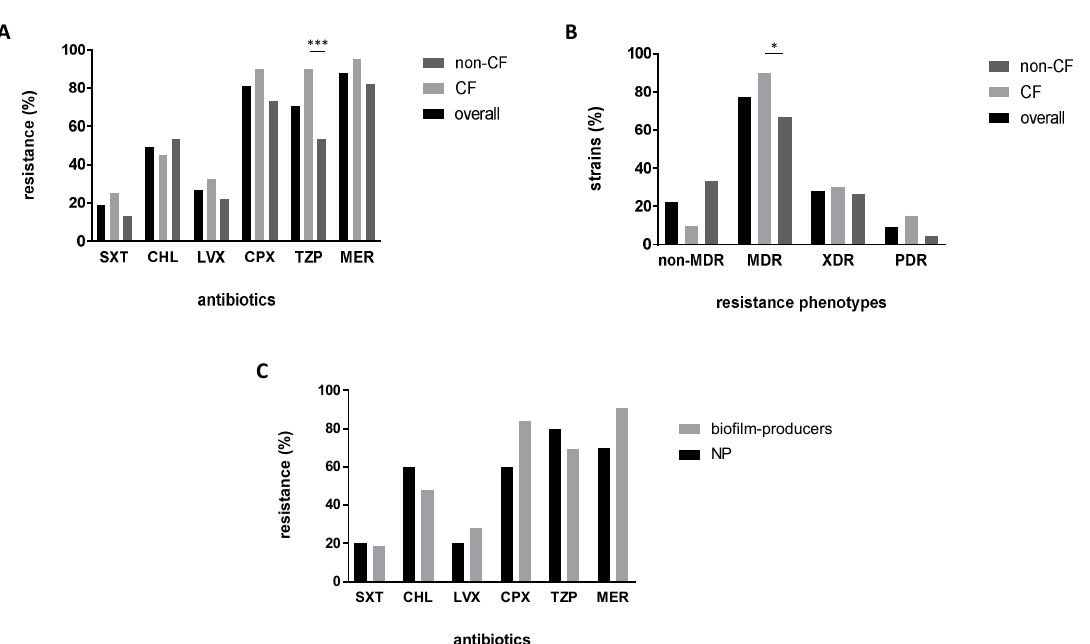
Figure 1. Distribution of antibiotic resistance rates and profiles. S. maltophilia strains were evaluated for in vitro susceptibility to six antibiotics: SXT, cotrimoxazole; CHL, chloramphenicol; LVX, levofloxacin; CPX, ciprofloxacin; TZP, piperacillin/tazobactam; MER, meropenem. The frequencies of ( A ) antibiotic resistances, and ( B ) multiresistance profiles (non-MDR, MDR, XDR, and PDR) were calculated for cystic fibrosis (CF) ( n = 40), non-CF ( n = 45), and overall ( n = 85) strains. ( C ) Resistance rates were calculated according to the capability to form biofilm: non-producers (NP; n = 10) or biofilm-producers ( n = 75; gathering strong, moderate, and weak-producers). Significance level at Fisher’s exact test: * p < 0.05; *** p < 0.001. Resistance profiles according to Magiorakos et al. [24]: MDR, multidrug-resistant strains; XDR, extensively drug-resistant strains; PDR, pandrug-resistant strains.